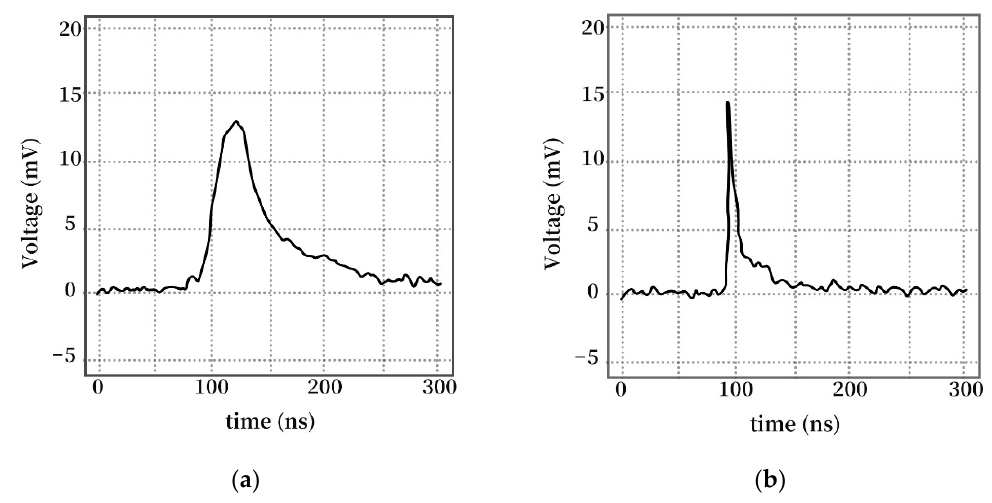
Figure 1. ( a ) Townsend type partial discharge [20], ( b ) streamer type partial discharge [20].